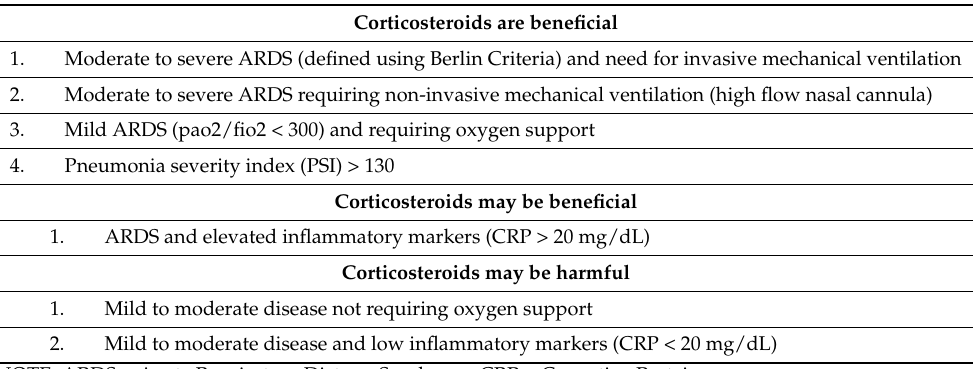
Table 2. Summarizing the indications for use of corticosteroids in